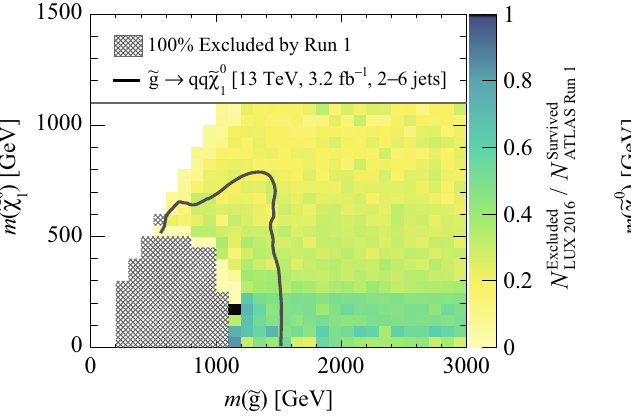
suchthatno13TeVanalysesareconsidered. Black straints N Survived ATLASRun1 bins denote 100% exclusion. Hatched grey bins indicate all the points are excluded by Run 1 ATLAS searches. Points with long-lived gluinos, squarks and sleptons are not considered in these figures. The overlayed grey solid lines correspond to the direct decay simplified models for gluino (Fig. 10a) and squarks (Fig. 10b) from the 2–6 jets search [1] LUX 2016